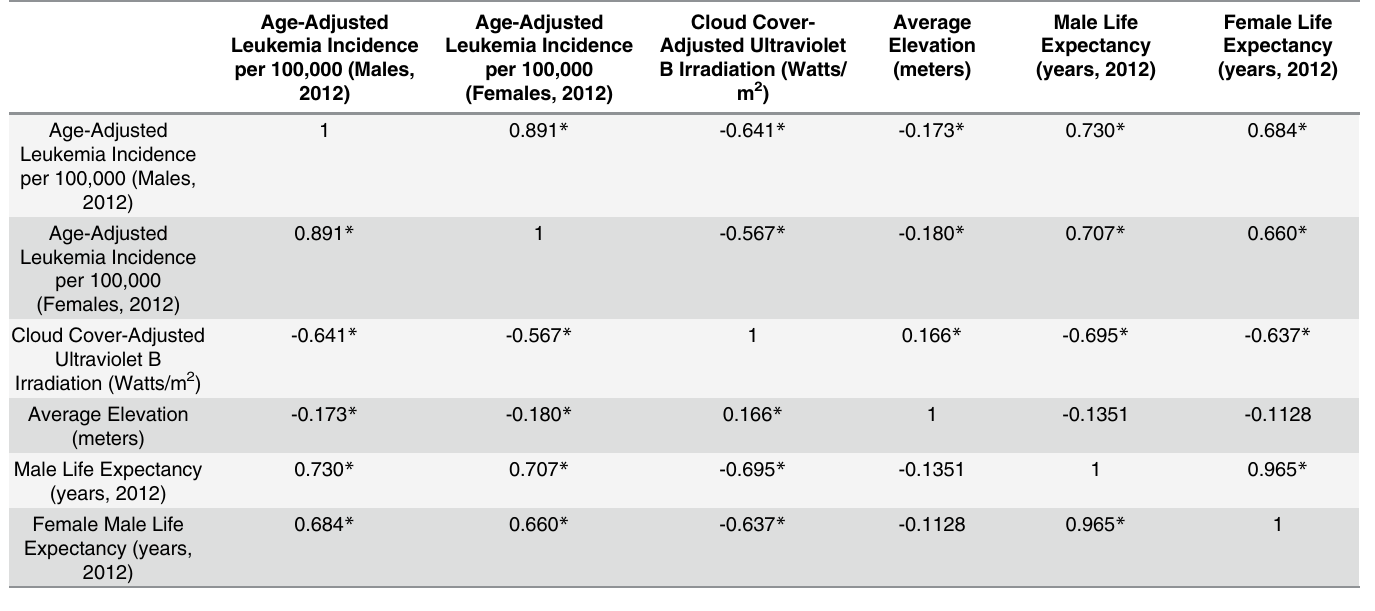
Table 1. Correlation matrix showing Pearson ’ s correlation coefficients for bivariate comparisons of all variables included in regression analyses.